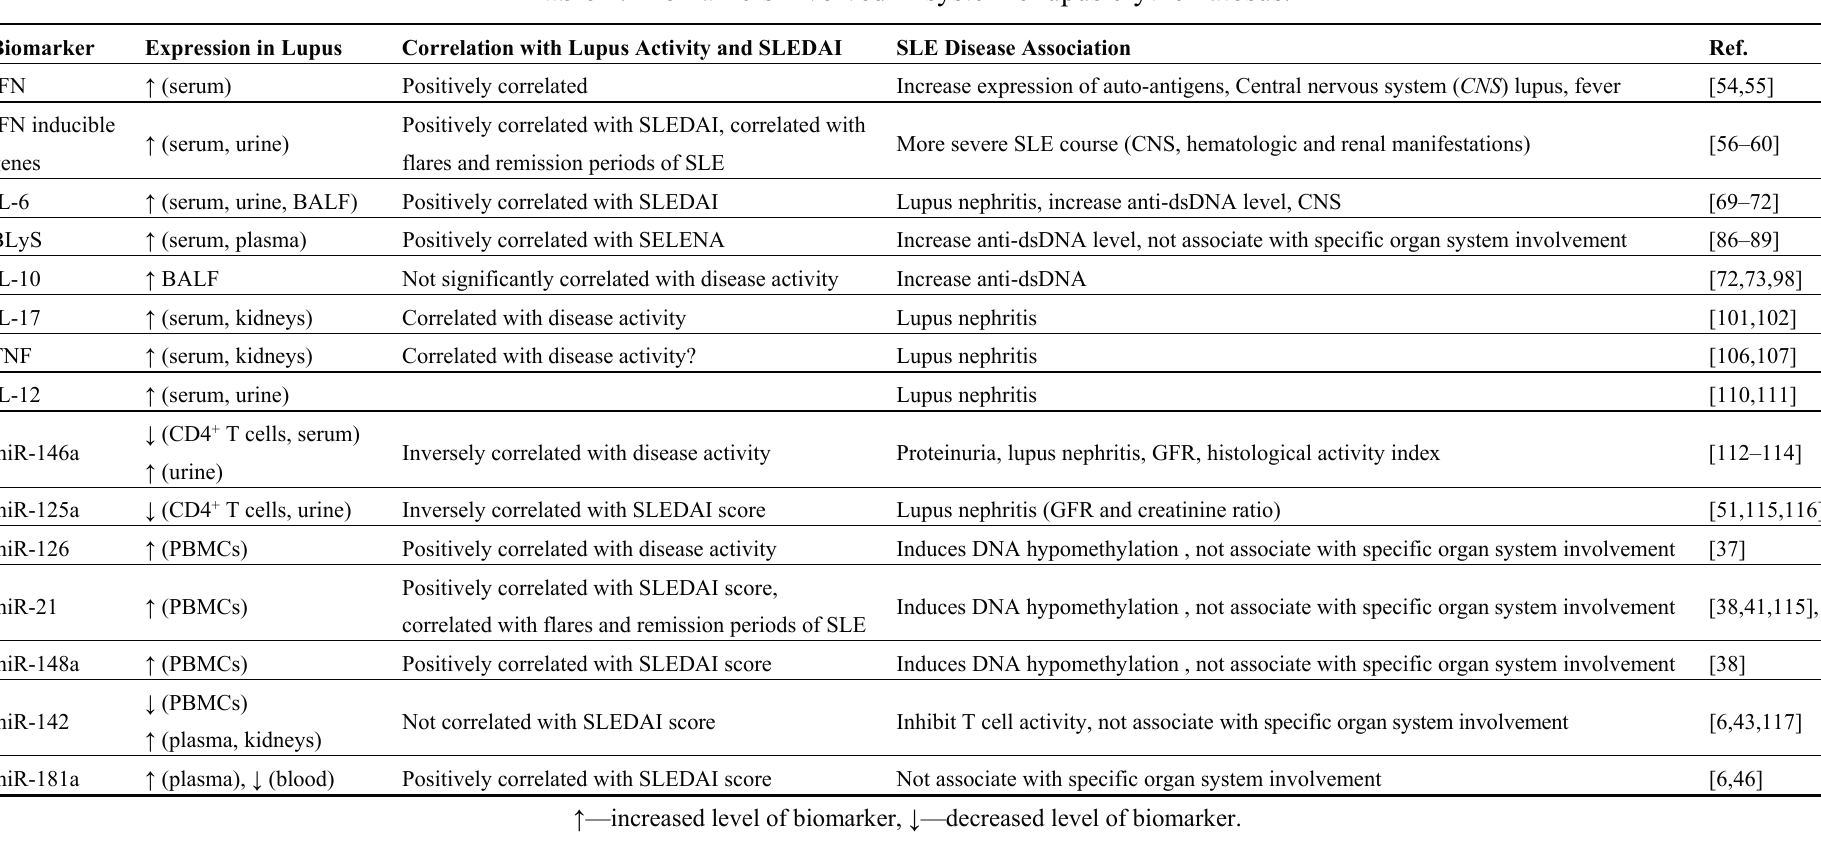
Table 1. Biomarkers involved in systemic lupus